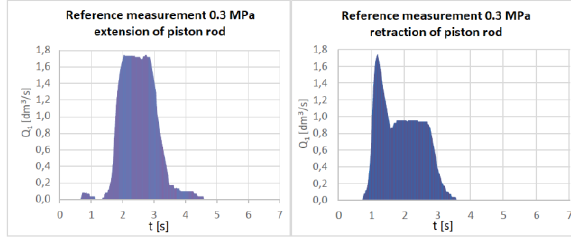
Fig. 8. Graph of sum areas under the flow rate curve, for working pressure 0.3